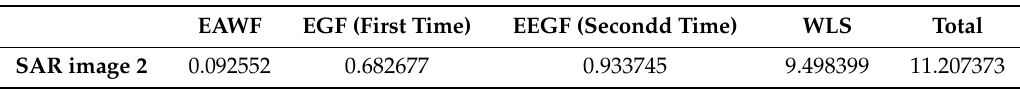
Table 16. Computational complexity results of all the filters in the proposed method for the real SAR image 2 (1323 ×